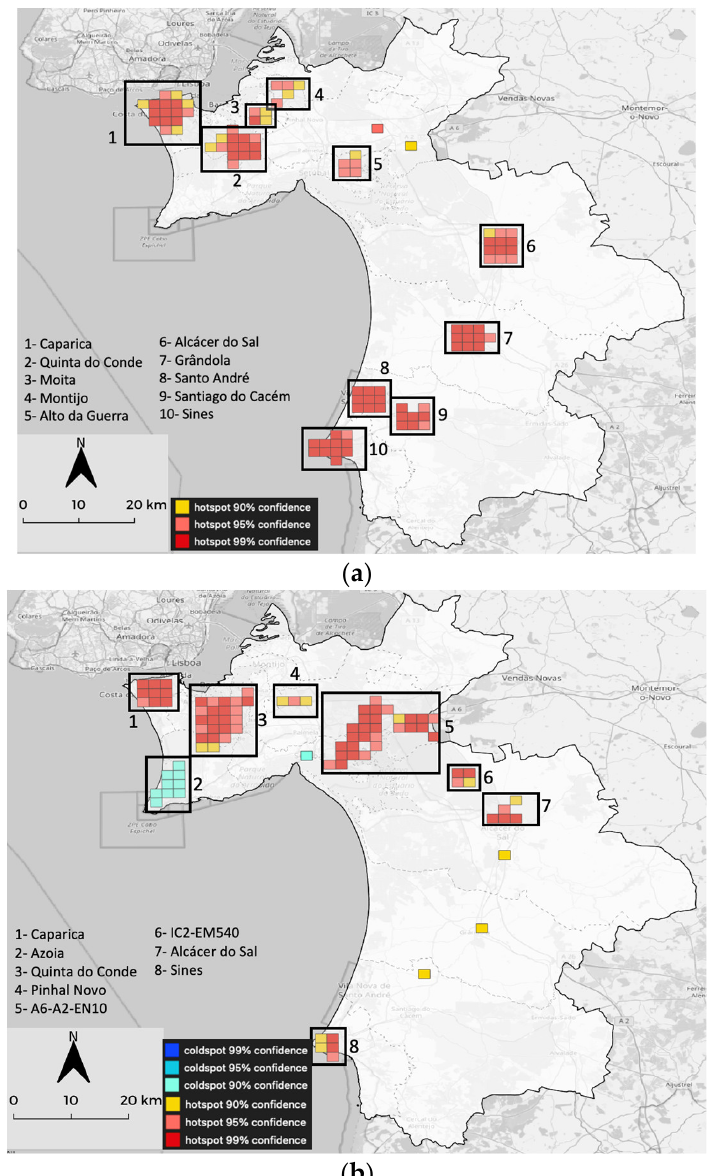
Figure 4. Getis-Ord Gi* hotspots for a cell size of 2 × 2 km with confidence levels of 99%, 95% and 90%. ( a ) Hotspots for a dataset I; and ( b ) hot and coldspots for dataset II.